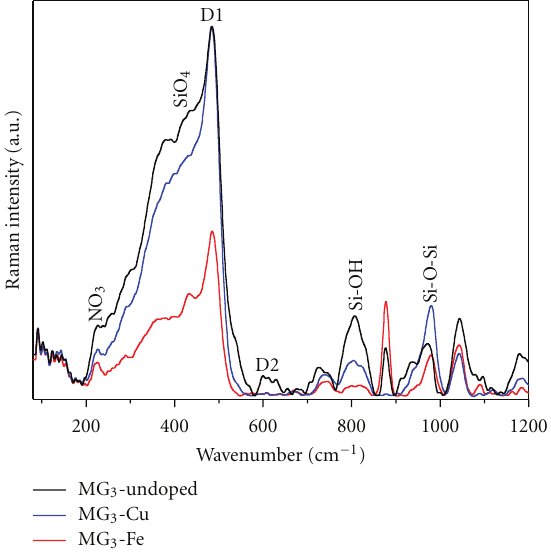
Figure 7: N 2 sorption on (a) MG 3